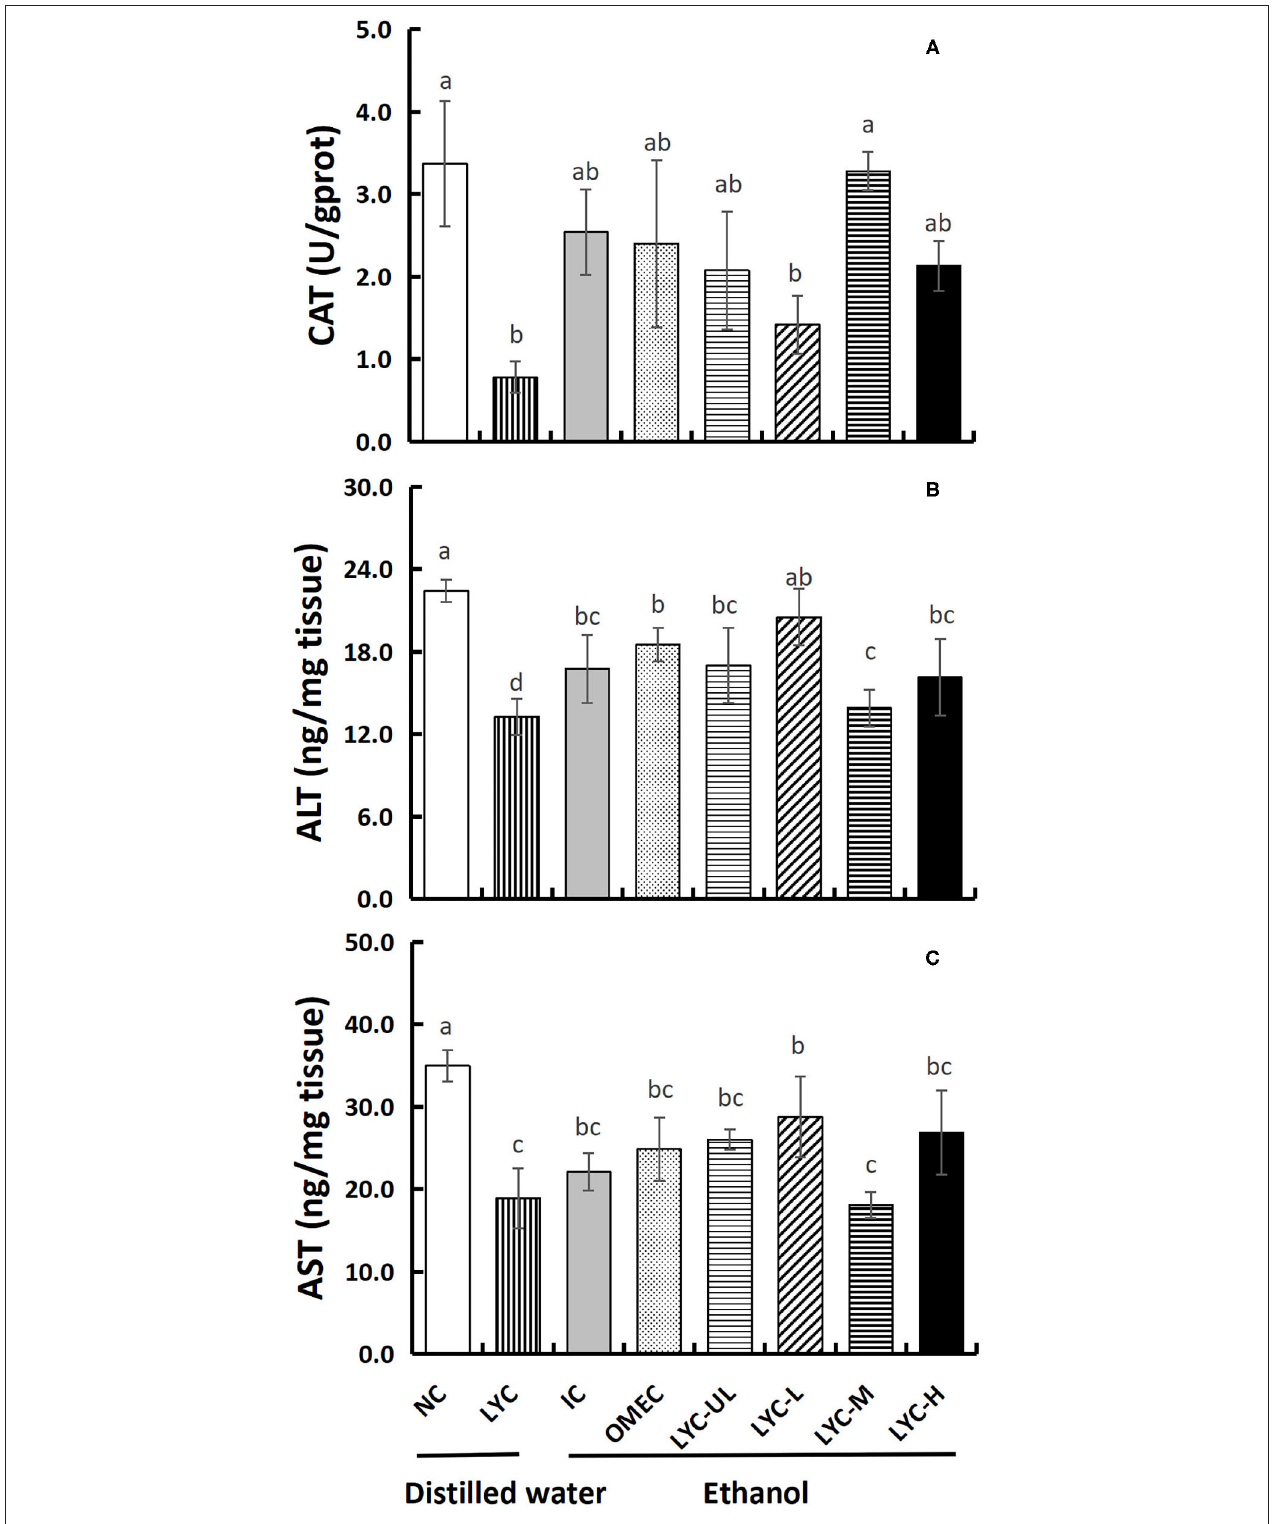
FIGURE 6 | Effect of lycopene on CAT, ALT, and AST of liver tissues. NC, normal control group; LYC, lycopene control group; IC, injury control group; OMEC, omeprazole control group; LYC-UL, ultralow-dose group; LYC-L, lycopene low-dose group; LYC-M, lycopene medium-dose group; LYC-H, lycopene high dose group. (A) Catalase (CAT). (B) Alanine aminotransferase (ALT). (C) Aspartate aminotransferase (AST). Values are means standard deviation of 14 mice and triplicate measurements. Different letters indicate significant differences ( P < 0.05) between different groups.